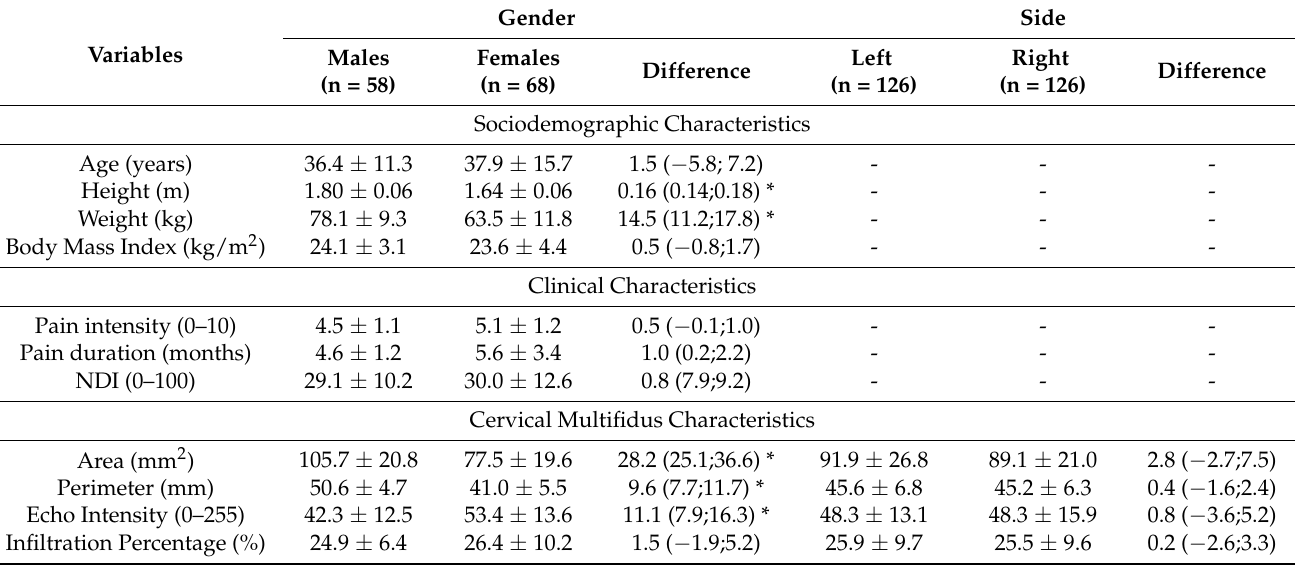
Table 1. Sociodemographic, clinical and ultrasound characteristics of the